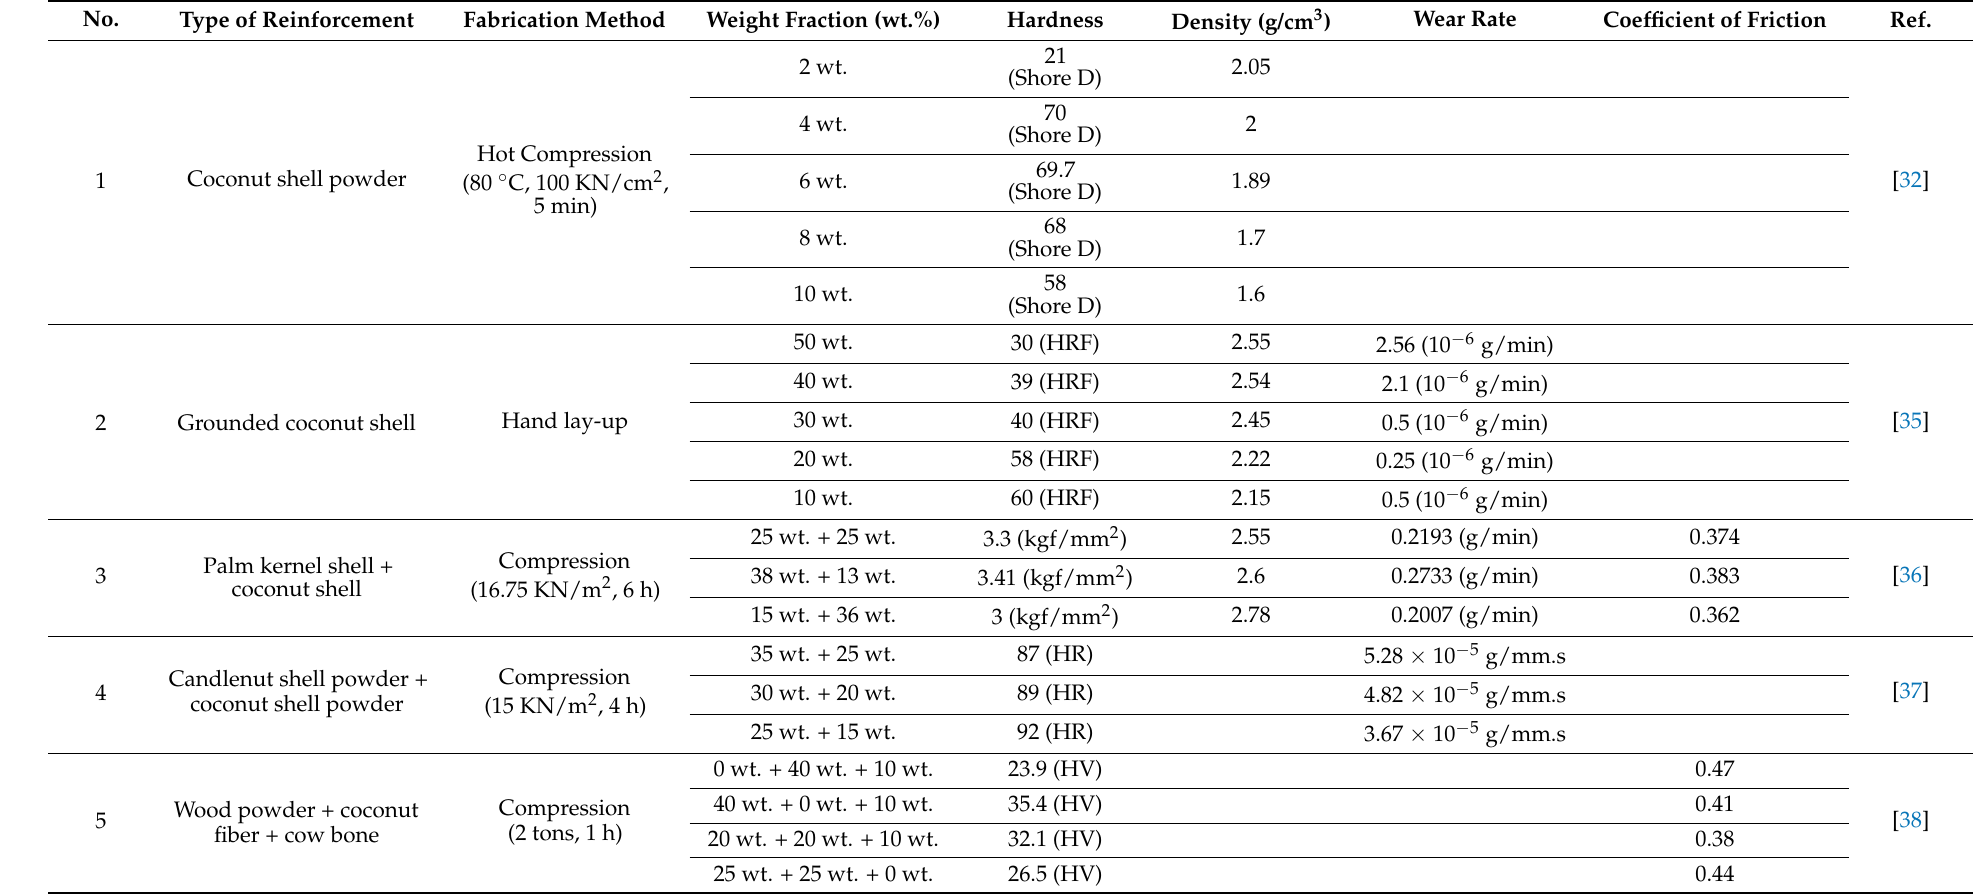
Table 2. The relation of the type of reinforcement and mechanical properties of non-asbestos brake